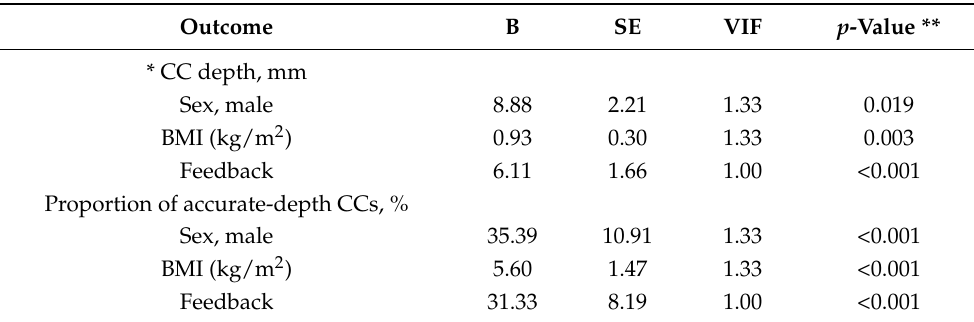
proportion of accurate-depth CCs was defined as the ratio of the number of CCs in which the depth was 5 to 6 cm to the total number of CCs. * p -value of less than 0.05 was considered a significant difference. Table 3. Multivariate analysis of chest compression depth and the proportion of accurate-depth chest